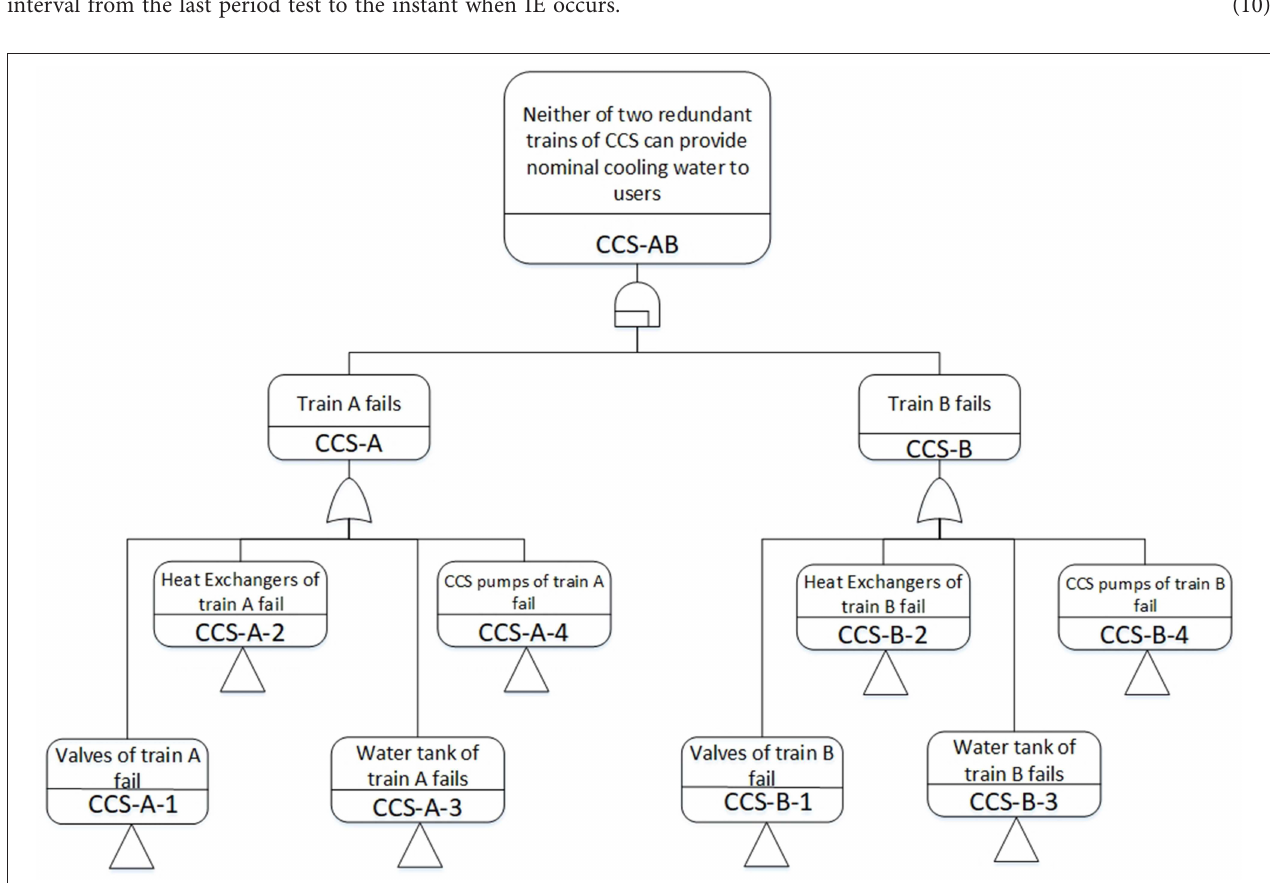
FIGURE 3 | Sequential FT of CCS